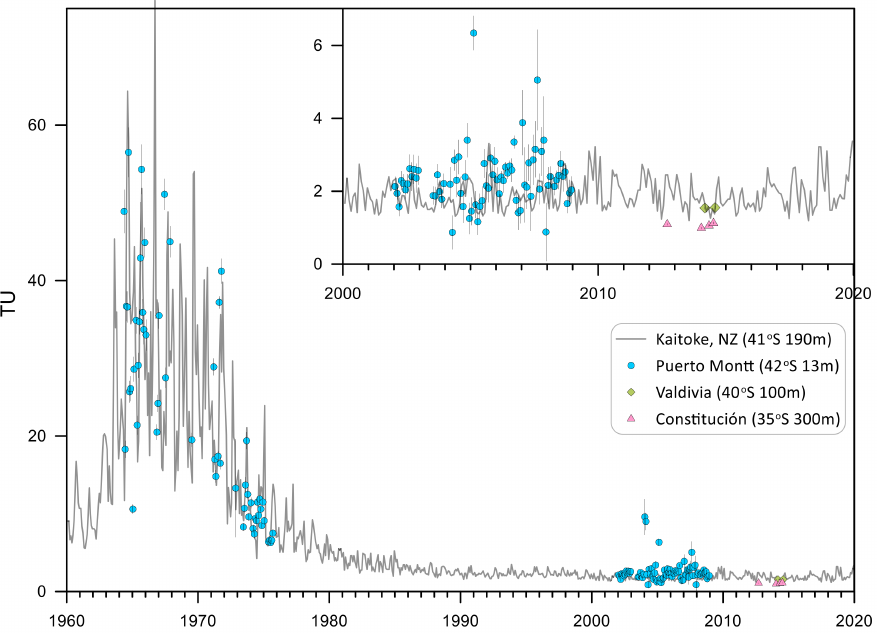
Figure 2. Tritium concentration of Chilean rain compared to rain from Kaitoke, New Zealand. Insert shows data with higher resolution for the last 20 years up to ≈ 6 TU. Also listed in the legend are the altitudes of the rain collection